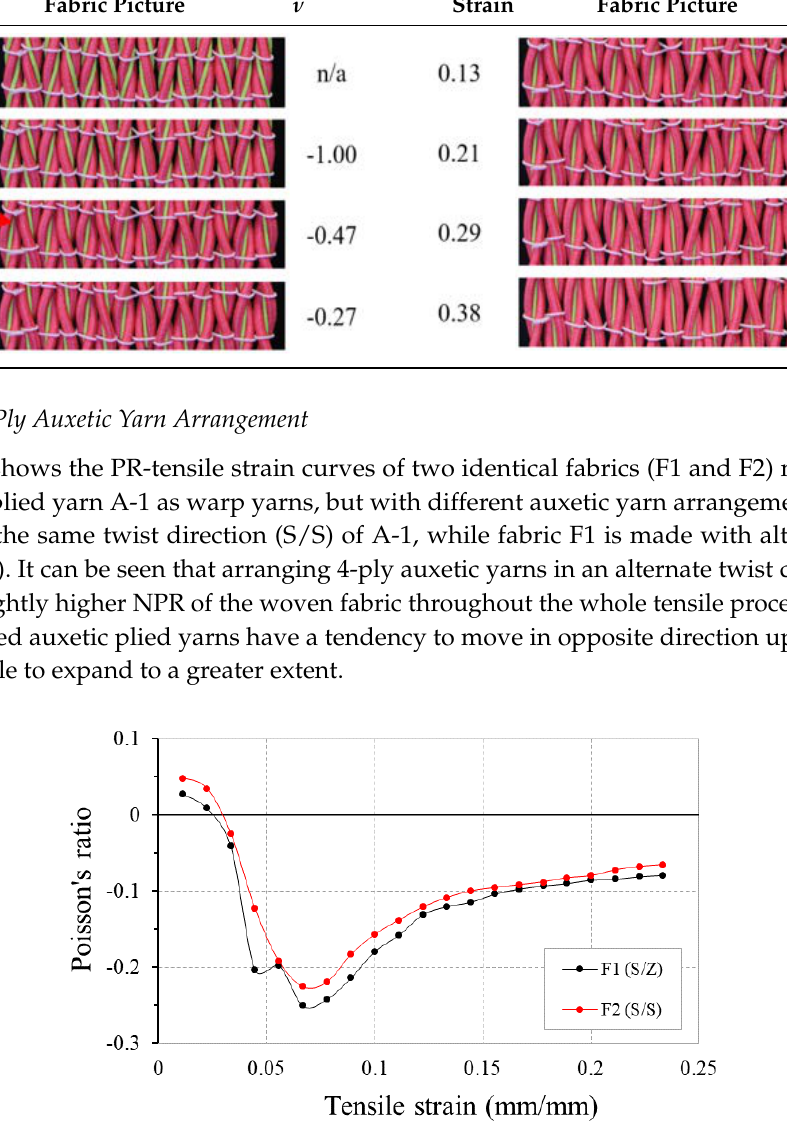
Figure 8. PR-tensile strain curves of fabrics F1 and F2 made of auxetic yarns with the same twist direction (S/S) and alternative twist direction (S/Z).